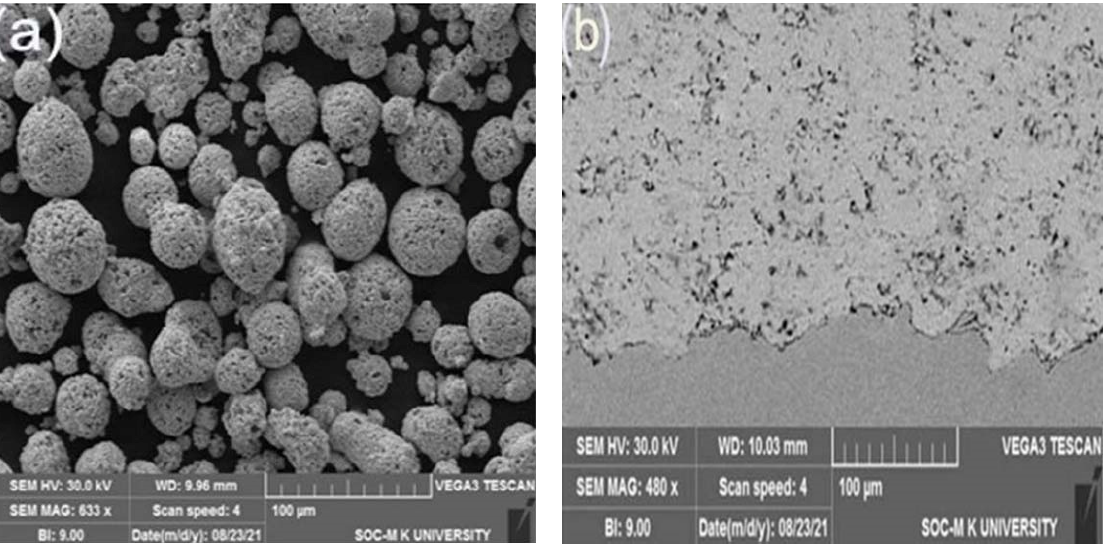
Figure 2. SEM micrographs of the WC-10Co powder and coatings. ( a ) WC-10Co powder; ( b ) WC- 10Co coating.